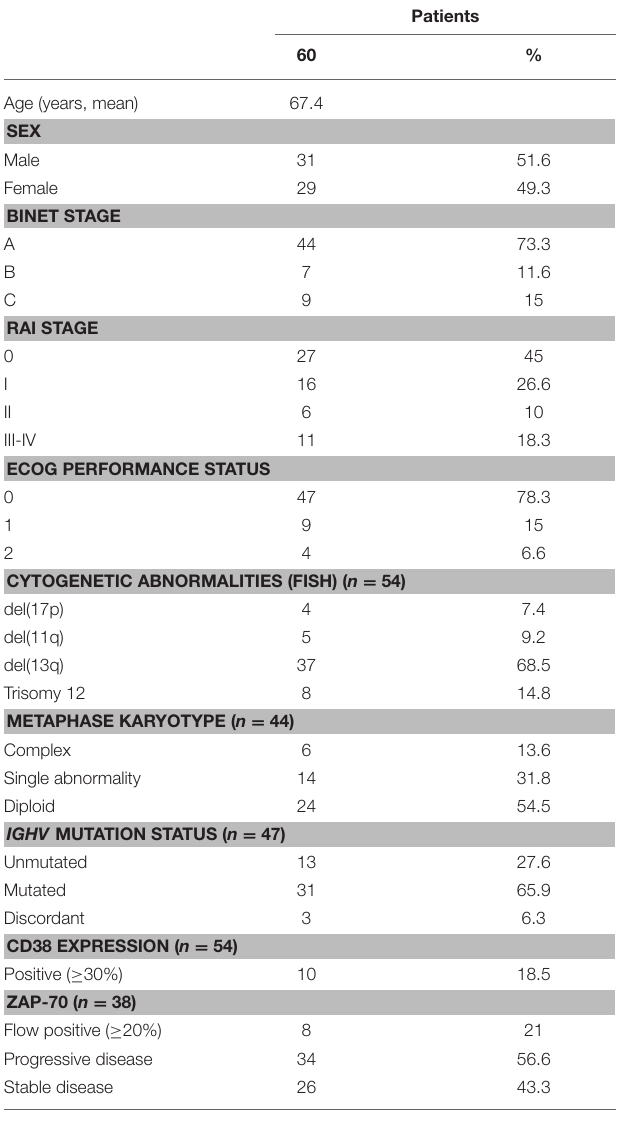
TABLE 1 | Clinical characteristics of CLL